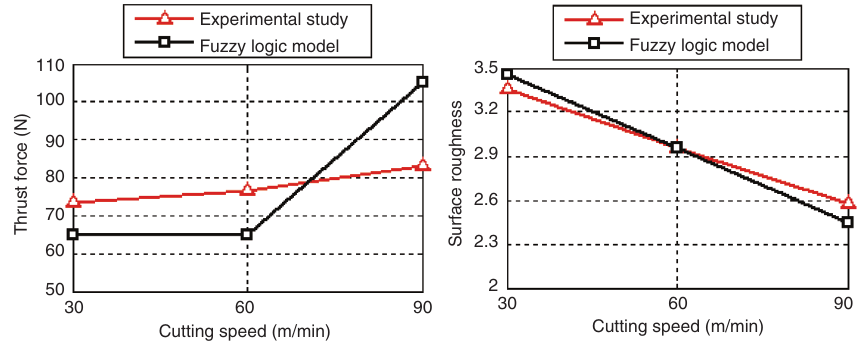
Figure 9 The effect on thrust forces and surface roughness of cutting